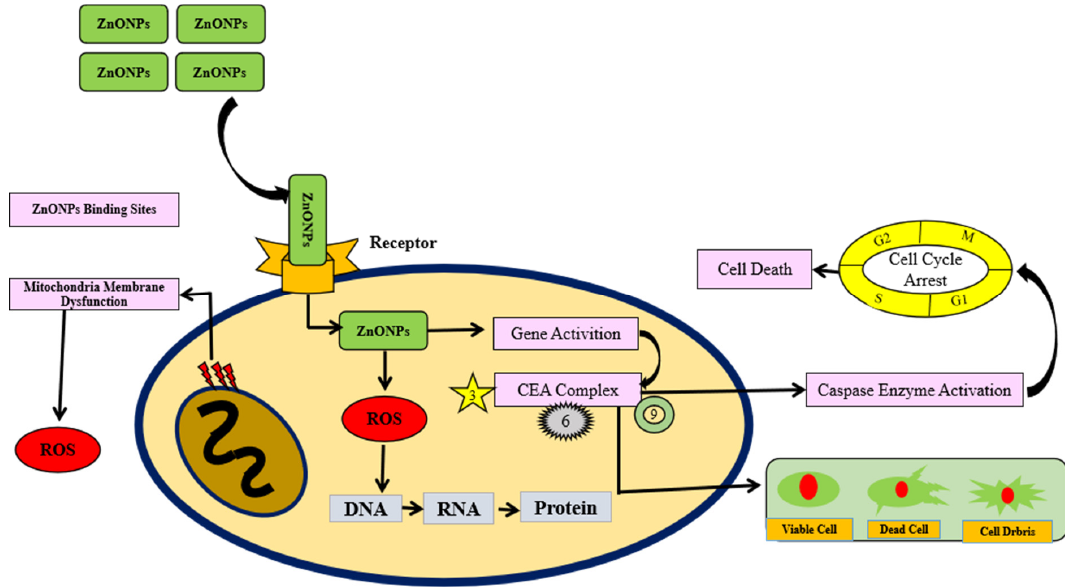
Figure 5. ZnONPs arrest the cancer cell cycle by generating ROS in effected cells. ZnONPs binds to receptors on the plasma membrane to enter the cell. ZnONP creates reactive oxygen species (ROS) in cytoplasm and then interaction with DNA brought structural changes in proteins. Secondarily, ZnONPs activate (p ‐ 53) genes via caspase enzyme activation (CEA) that arrest cancerous cell cycle at synthesis phase (S ‐ phase) leading to cancer cell death.